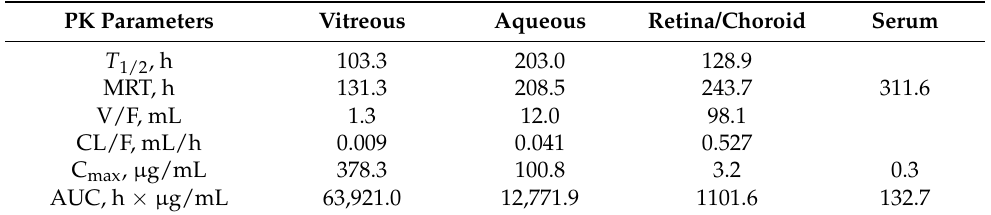
Table 1. PK parameters of NN2101 in the vitreous humor, aqueous humor, retina/choroid, and serum of rabbits.